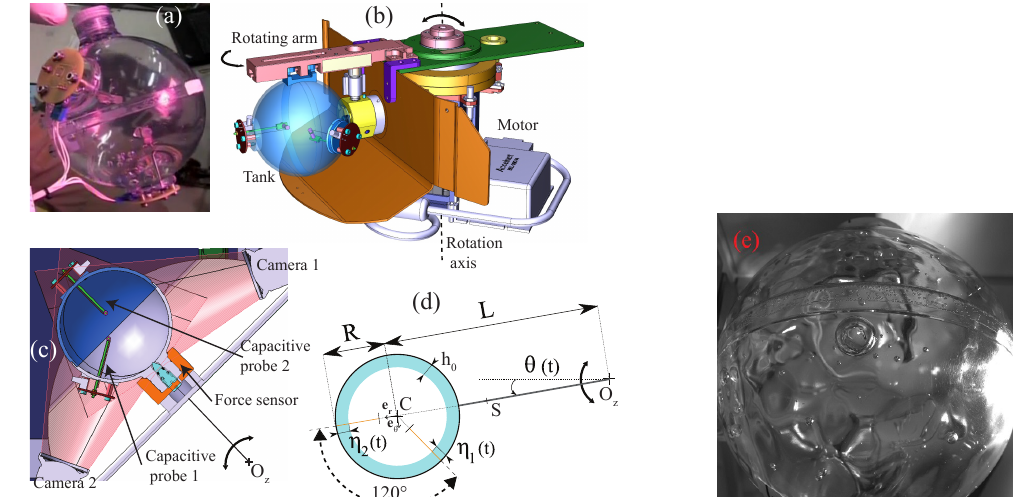
Figure 18. ( a ) Picture of the experimental spherical tank. The cylinder visible on the top of the picture is the filling orifice and the fastening point. The two circular electronic boards measure the capacity for each fluid height probe. ( b ) Technical drawing of the experiment without the acquisition system and the cameras ( Airbus Defence and Space ©). ( c ) Horizontal cross-section through the center of the tank. ( d ) Schematic view of the experiment, R = 100mm, L = 175.4mm, h 0 = 5.6 mm. ( e ) Snapshots of the tank from camera 1, for a strong sinusoidal forcing. Presence of air bubbles is noted. (Reprinted with permission from Ref. [115] Copyright 2022 European Physical Society).